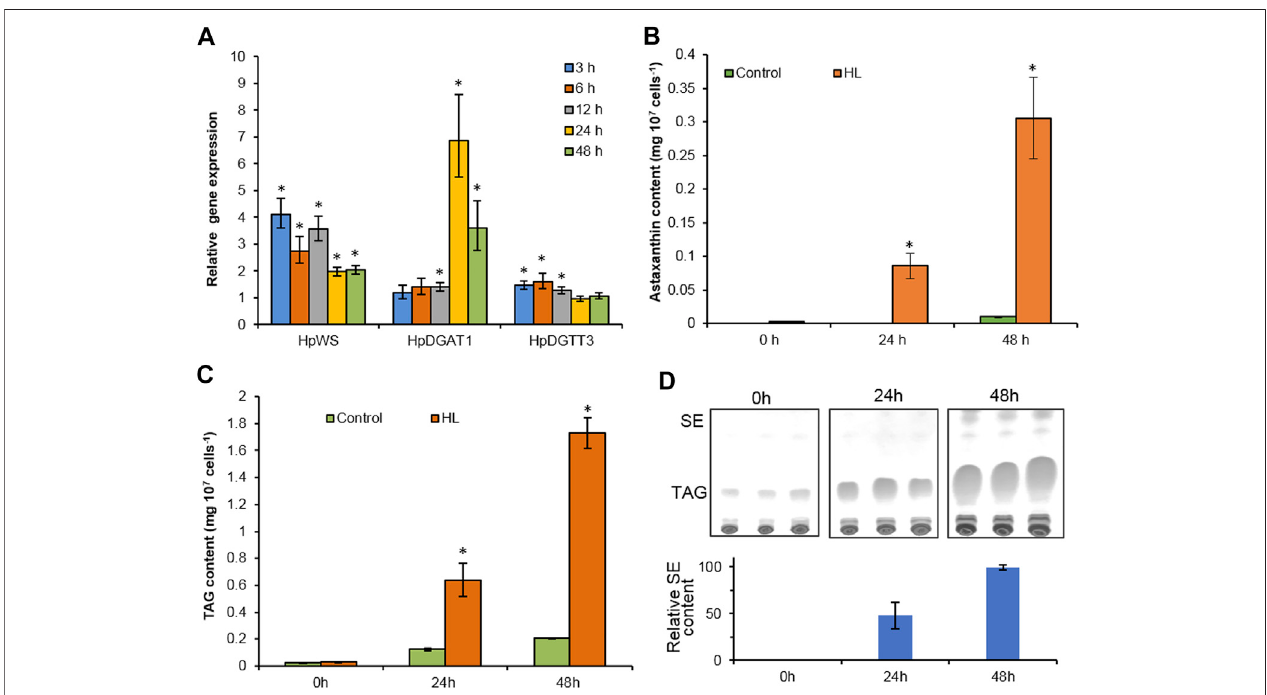
FIGURE 3 | High-light-induced accumulation of neutral lipids in Haematococcus pluvialis NIES-144 . (A) The relative gene expression of HpWS , HpDGAT1 , and HpDGTT3 . (B) Astaxanthin content. (C) TAG content. (D) Thin-layer chromatography (TLC) separation of sterol esters produced. Control, low light; HL, high light; TAG, Triacylglycerol; SE,sterol ester. Dataareexpressed asmean ± SD, n (cid:1) 3.* p < 0.05 (Student ’ s t -test).The lipidresidue wasre-established inchloroform,and thevolume was normalized to cell number. An equal volume of each sample was loaded on TLC for separation.